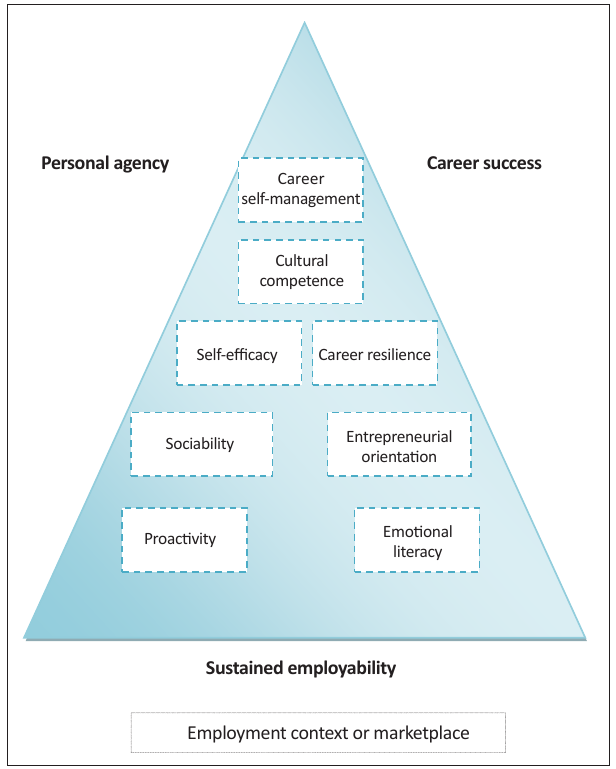
FIGURE 1: Conceptual overview of the skills and attributes that underlie people’s